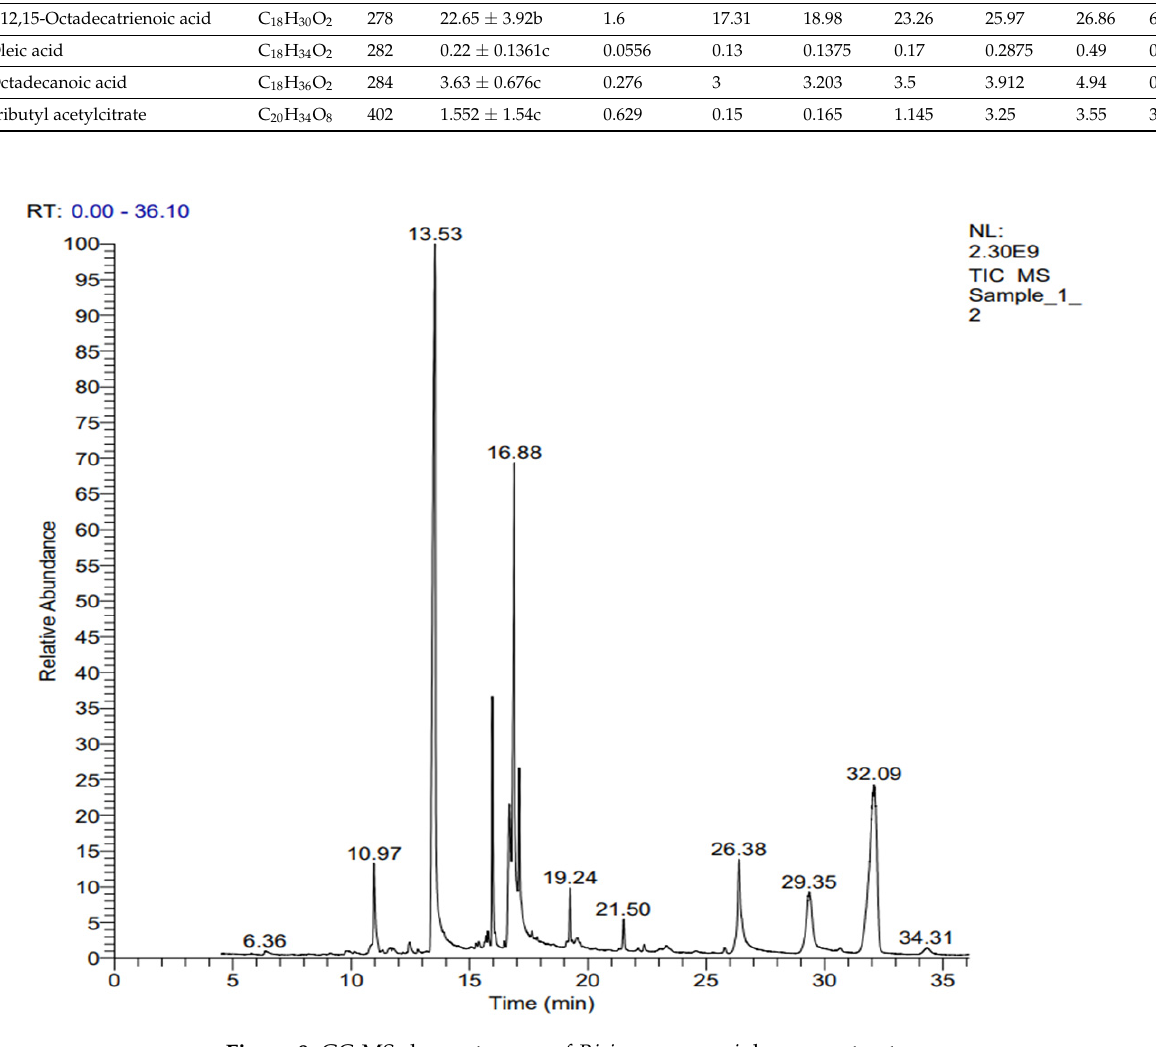
Figure 8. GC-MS chromatogram of Ricinus communis hexane extract. Six major common compounds were detected in the chromatograms of the studied samples. Oleic acid represented the lowest values for the studied samples. The highest percentages for n-Hexadecanoic acid (36.25%) and 9,12,15-Octadecatrienoic acid (26.86%) were recorded in the hexane extract of site 5, whereas their lowest values were recorded for sites 10 and 1, respectively. The highest concentration of Isophytol was detected